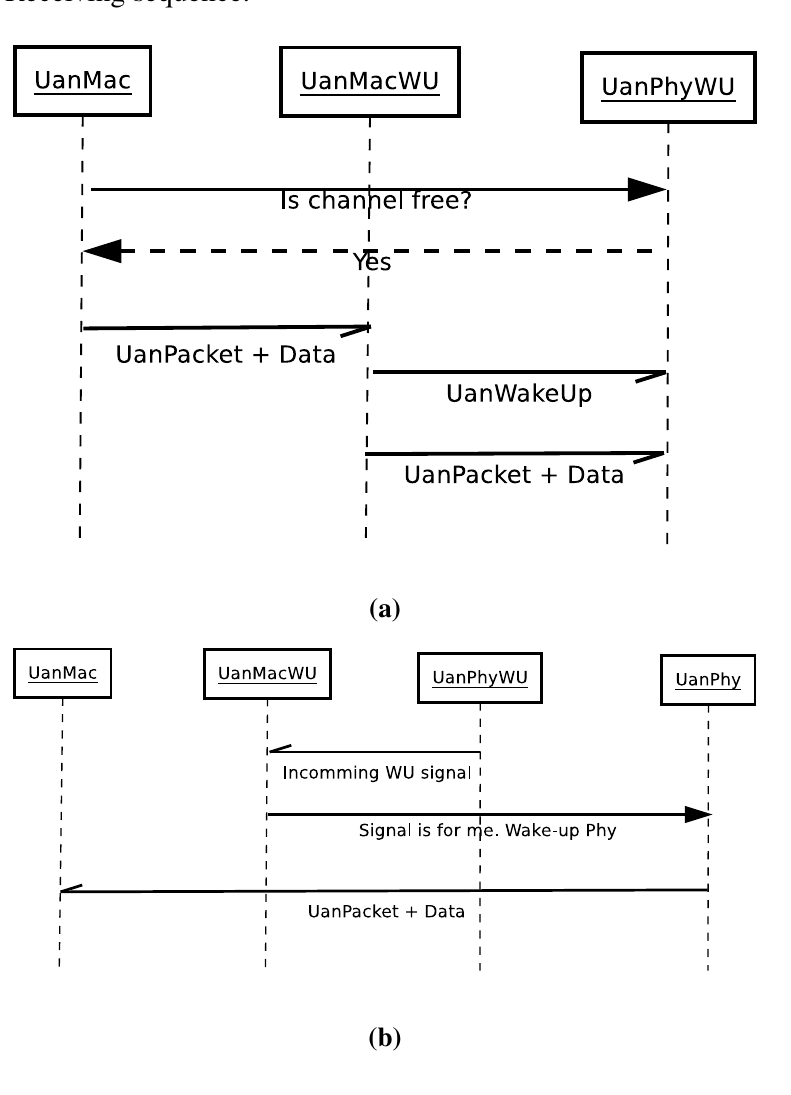
Figure 4. Interaction diagram between the radio model and the wake-up model. ( a ) Sending sequence; ( b ) Receiving